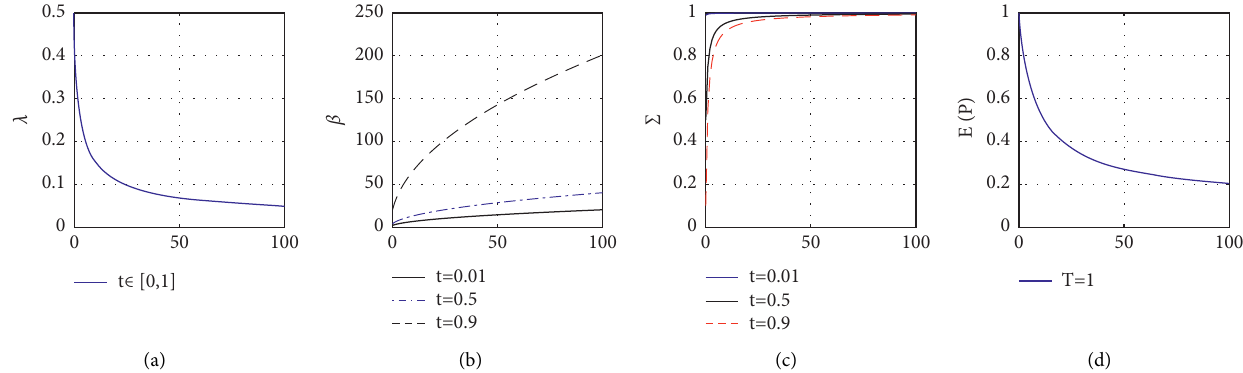
Figure 2: Market liquidity λ , trading intensity β , residual information Σ , and insider’s total expectation profit E ( P ) varying with volatility σ 2 of noise in risk asset value at different time t . (a) λ varying with σ 2